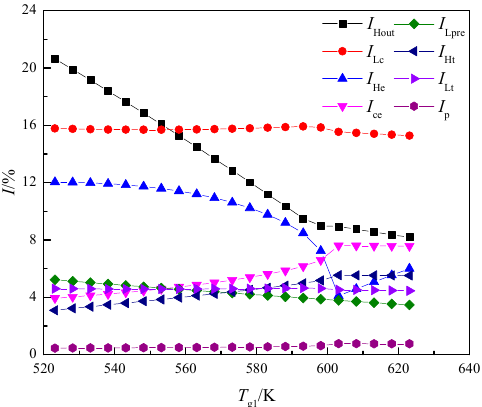
Figure 15. Effects of T g1 on exergy destruction rate for the cyclohexane system.